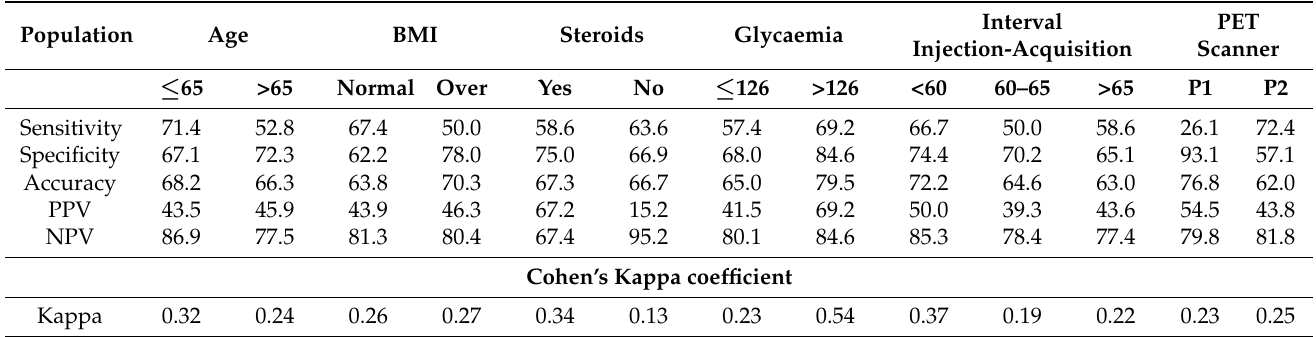
Table 4. Diagnostic performances of reader 2 detailing the values of sensitivity, specificity, accuracy, PPN, NPV, and Cohen’s Kappa overall and in each subset of patients.